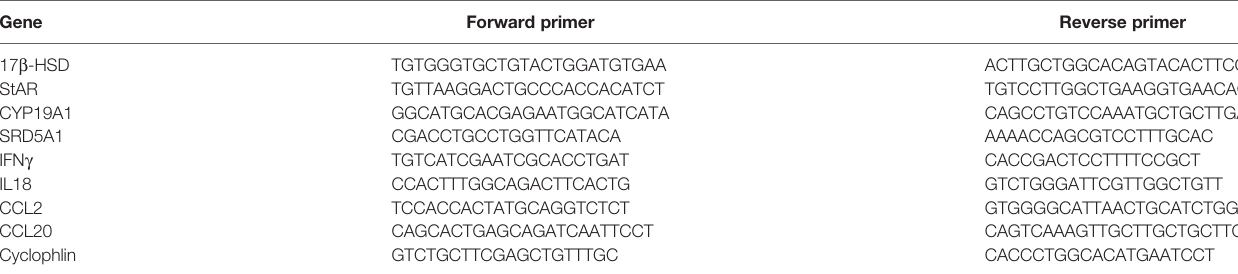
TABLE 1 | Primers for RT-PCR, related to